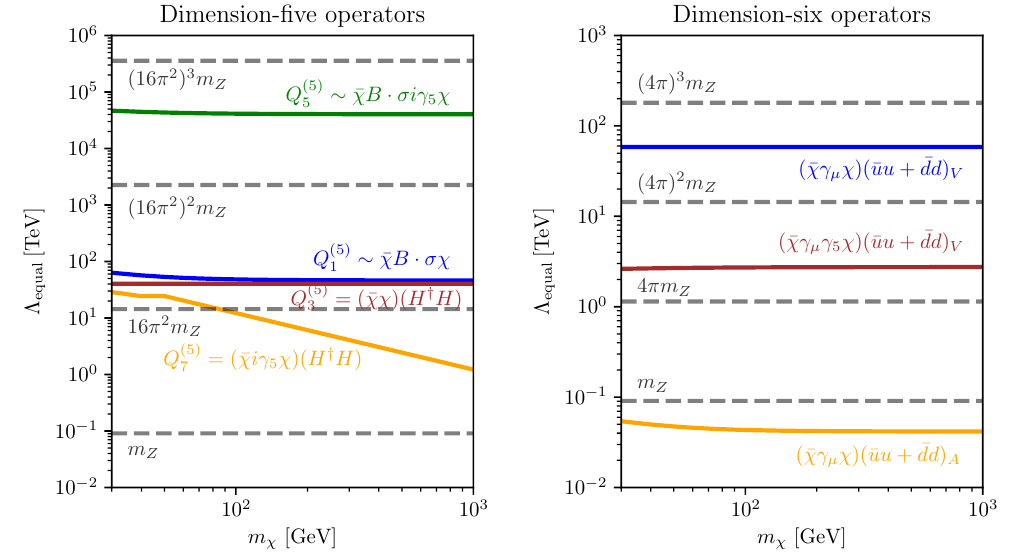
Figure 3 . The contribution from the non-renormalizable operator Q ( d ) dominates in direct de- i tection scattering over the renormalizable contributions, if the suppression scale (cid:3) is below the corresponding solid line (i.e., for (cid:3) = (cid:3) equal the non-renormalizable and the renormalizable con- tributions are of the same size). Examples shown are for triplet Dirac fermion DM with Y (cid:31) = 0 scattering on a Xenon target, so that the contributions from renormalizable interactions start at one-loop. The dashed gray lines denote the electroweak scale, m Z , and the scales roughly n loop factors above it, (4 (cid:25) ) 2 n m Z on the left and (4 (cid:25) ) n m Z on the right. Dimension-(cid:12)ve operators are shown in the left panel, dimension-six operators in the right